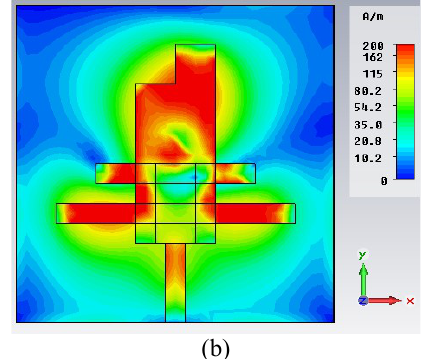
Fig. 5. Surface current distributions (Proposed antenna) (a) At 16 GHz (b) At 30.45 GHz The gain and side lobe variations have been shown in fig. 6 and 7 for the lower layer and final two layers proposed structure respectively. With one layer, the antenna is showing a gain of about 6.9 dBi and 5.9 dBi at the two resonant frequencies respectively.